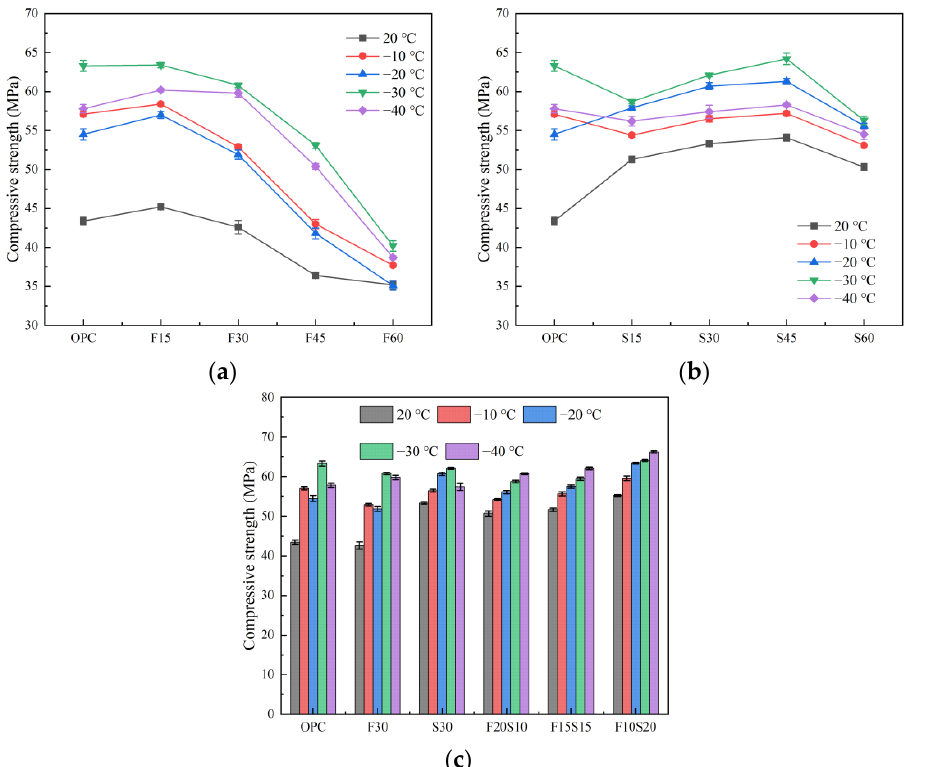
Figure 3. Compressive strength of the concrete. ( a ) Mixed with fly ash, ( b ) mixed with slag, and ( c ) mixed with fly ash and slag.